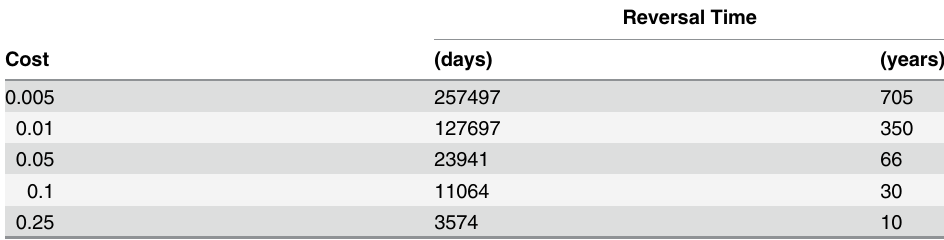
Table 2. Reversal times for a MRP population and various costs.